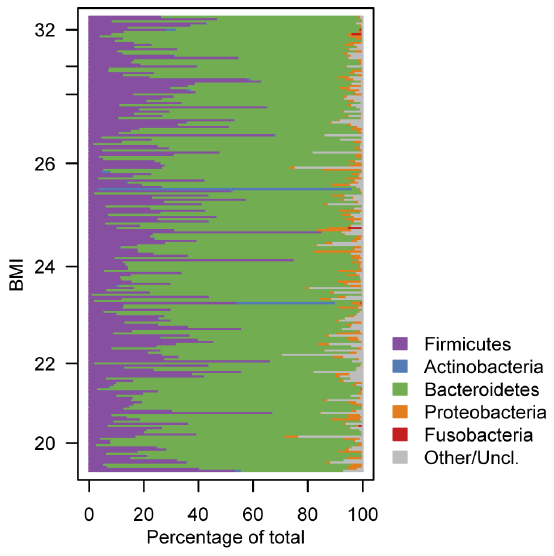
Figure 2. There is no relationship between BMI and the phylum-level composition of the microbiome. Each row shows the relative abundance of major gut bacterial phyla in an individual. Individuals are ordered according to their